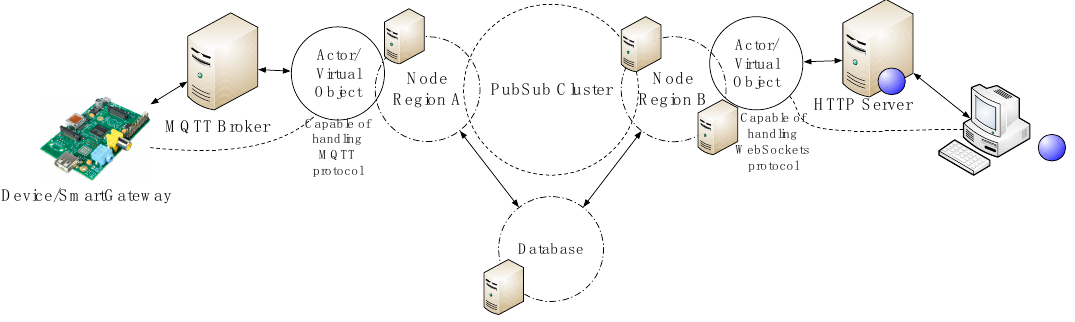
Figure 5. Layer schematic for a Ubiquitous Sensor Network (USN) applied to Smart Grids.